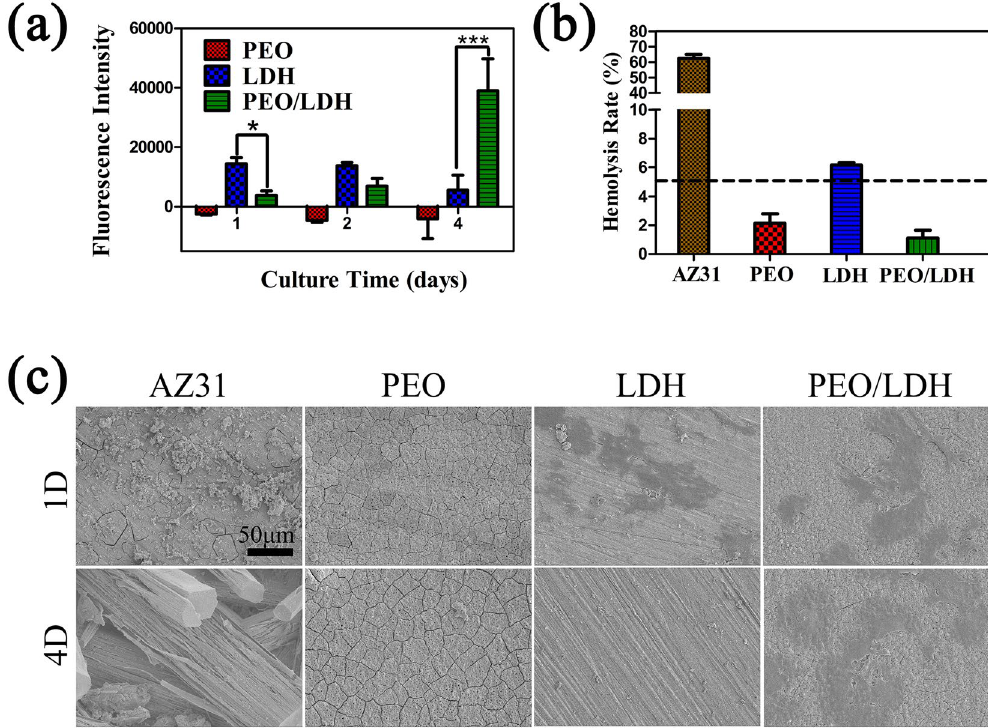
Figure 10. The proliferation rate ( a ) and morphology ( c ) of cells cultured on various surfaces; Hemolysis rate of all samples ( b ).